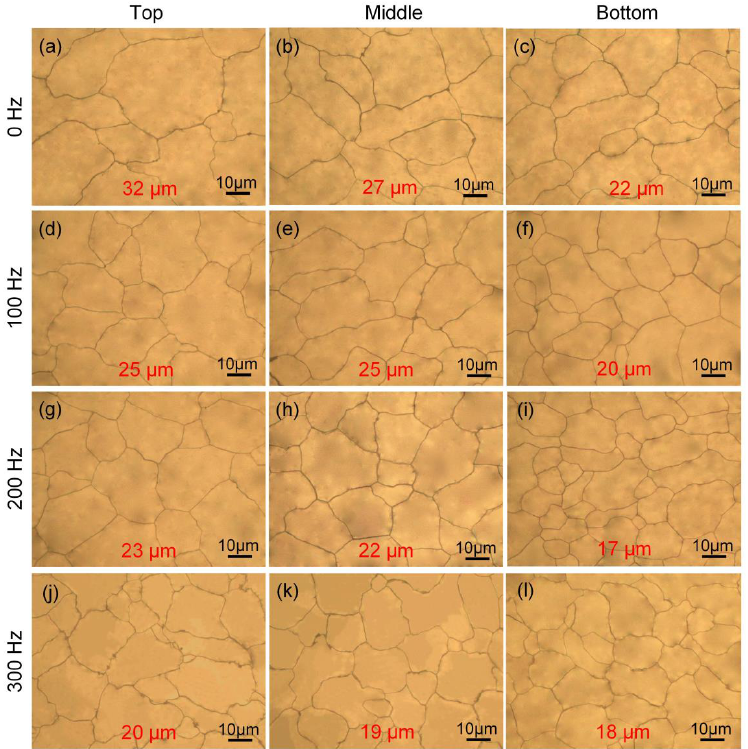
Figure 6. OM grain size of the AZ31 alloy at various positions from 0 Hz to 300 Hz. ( a – c ) 0 Hz; ( d – f ) 100 Hz; ( g – i ) 200 Hz; ( j – l ) 300 Hz. The SEM micrographs in different positions of the thin-walled components from 0 Hz to 300 Hz are given in Figure 7. It can be seen that there are white particles of different sizes distributed on the dark substrate. As shown in Figure 8a, the phase composition was tested and calibrated using XRD, and three main phases, α -Mg, Al 8 Mn 5 , and Mg 17 Al 12 , were detected. Due to the low content of Al and Mn elements in AZ31 magnesium alloy, the heights of the diffraction peaks of the Al 8 Mn 5 and Mg 17 Al 12 phases were very dwarfed. As shown in Figure 8b – d, the compositions of different microstructures were examined using EDS, and the detailed chemical compositions are shown in Table 3. The dark sub- strate is composed of α -Mg and a small amount of solidly solved Al atoms. The atomic ratio of Al and Mn elements in the large granular precipitates is about 1.51, which is sim- ilar to that of Al 8 Mn 5 . The small granular precipitation is the Mg 17 Al 12 phase because no Mn elements are detected, but the Zn content is high for the reason that some Zn atoms can replace Al atoms to form the Mg 17 (AlZn) 12 phase [24]. Therefore, the EDS test results confirm the XRD results. In addition, a large amount of Mg elements was detected in all of the particles, which is because the spot range of EDS is larger than the size of the pre- cipitates. Further, the size difference between the precipitated phases is due to the direct precipitation of the Al 8 Mn 5 phase from the liquid phase, in which Al and Mn atoms can